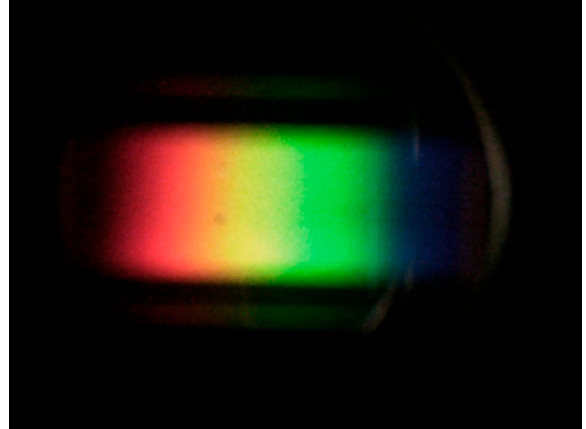
Figure 2. An example of a spectrum captured using PHYLIS, as taken by the camera attached to the device. Sensors 2017 , 17 , 99